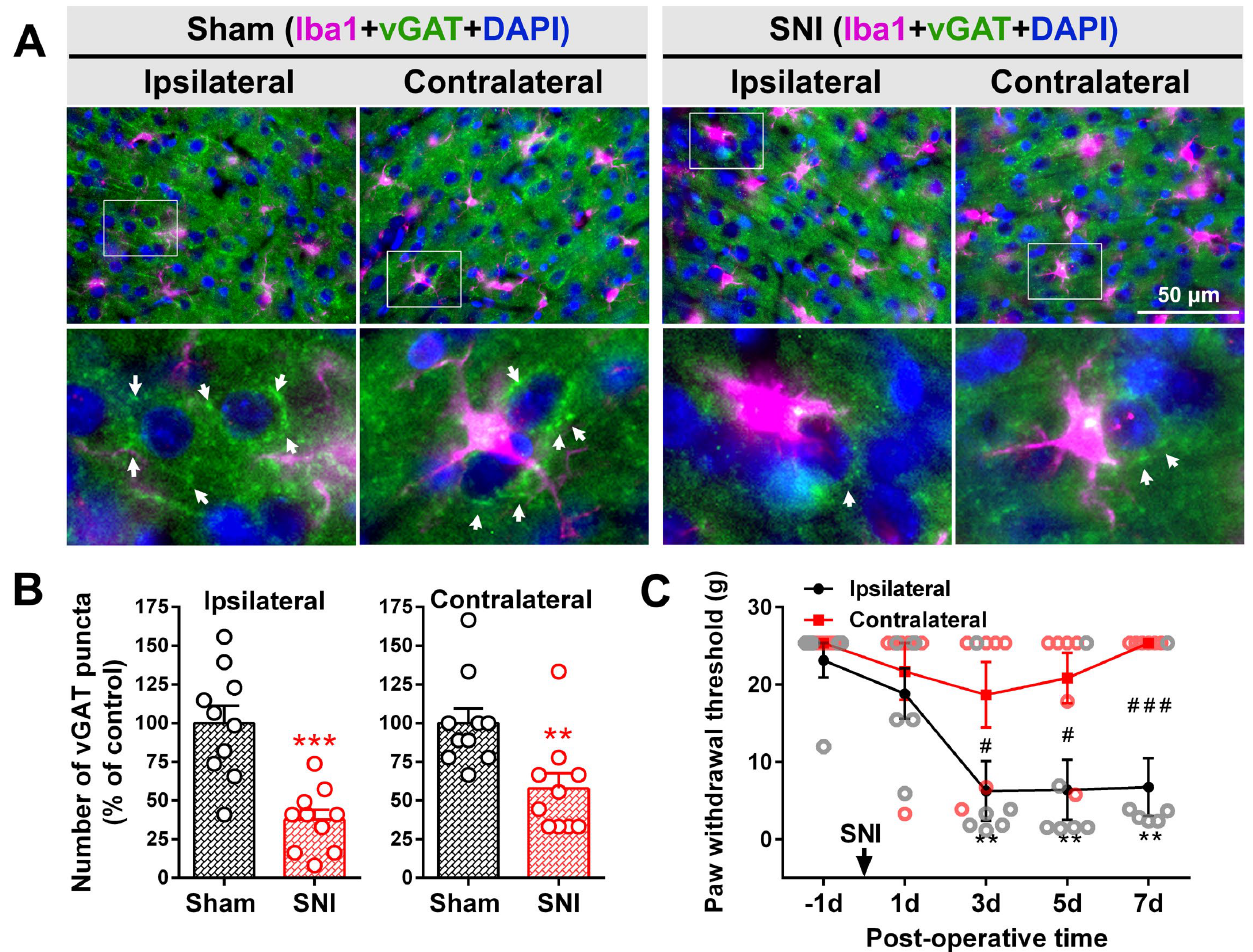
Figure 4. SNI triggers the loss of inhibitory synaptic terminals in the bilateral ACC. ( A ) Representative double immunofluorescence staining image showing somatic vGAT puncta-IR (inhibitory synaptic terminal marker, green) in the sham and SNI groups and the somatic adhesion of Iba1-IR (microglial marker, magenta) in the bilateral ACC. Scale bar = 50 µ m. The enlarged image in the white box is shown below and the white arrow shows the vGAT puncta signal. Blue fluorescence is from DAPI, a nuclear counterstain. ( B ) Comparison of the number of vGAT-IR puncta in the bilateral ACC of sham and SNI groups. ** p- value < 0.01, *** p- value < 0.001 versus the sham (unpaired t test). ( C ) Changes in the bilateral mechanical paw withdrawal thresholds of SNI rats. Significant differences were observed in the threshold for the ipsilateral paw on PO days 3, 5, and 7 ( n = 6). ** p- value < 0.01 versus PO day −1 (Dunn’s multiple comparisons test) or # p- value < 0.05, ### p- value < 0.001 versus the contralateral side (multiple t test).